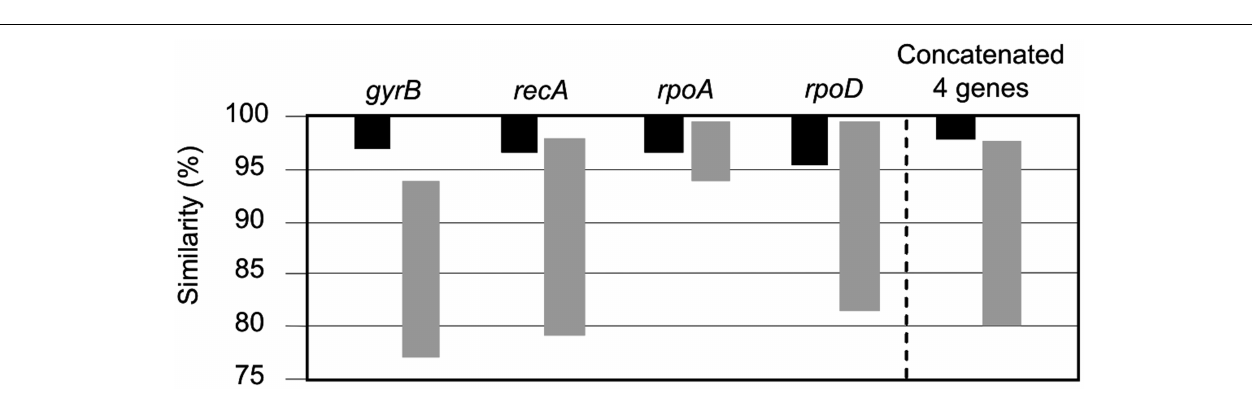
FIGURE 5 | Taxonomic resolution based on the intra-phylogroup (black bars) and inter-phylogroup (gray bars) ranges of similarity